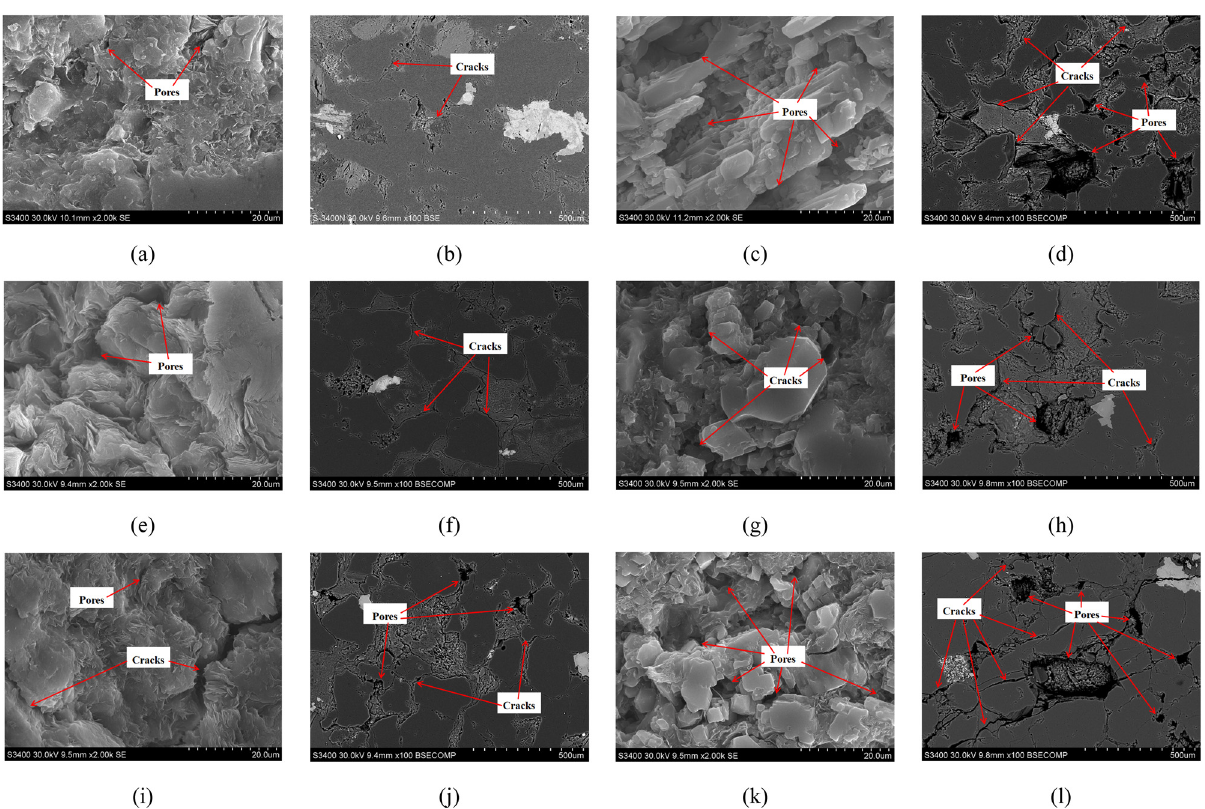
Figure 9: Microstructure of sandstone: ( a ) 20°C (× 2,000 ) , SEM results. ( b ) 20°C, EDS results. ( c ) After 12 cycles in H - T group (× 2,000 ) , SEM results. ( d ) After 12 cycles in H - T group, EDS results. ( e ) After 10 cycles in L - T group (× 2,000 ) , SEM results. ( f ) After 10 cycles in L - T group, EDS results. ( g ) After 40 cycles in L - T group (× 2,000 ) , SEM results. ( h ) After 40 cycles in L - T group, EDS results. ( i ) After 10 cycles in M - T group (× 2,000 ) , SEM results. ( j ) After 10 cycles in M - T group, EDS results. ( k ) After 40 cycles in M - T group (× 2,000 ) , SEM results. ( l ) After 40 cycles in M - T group, EDS